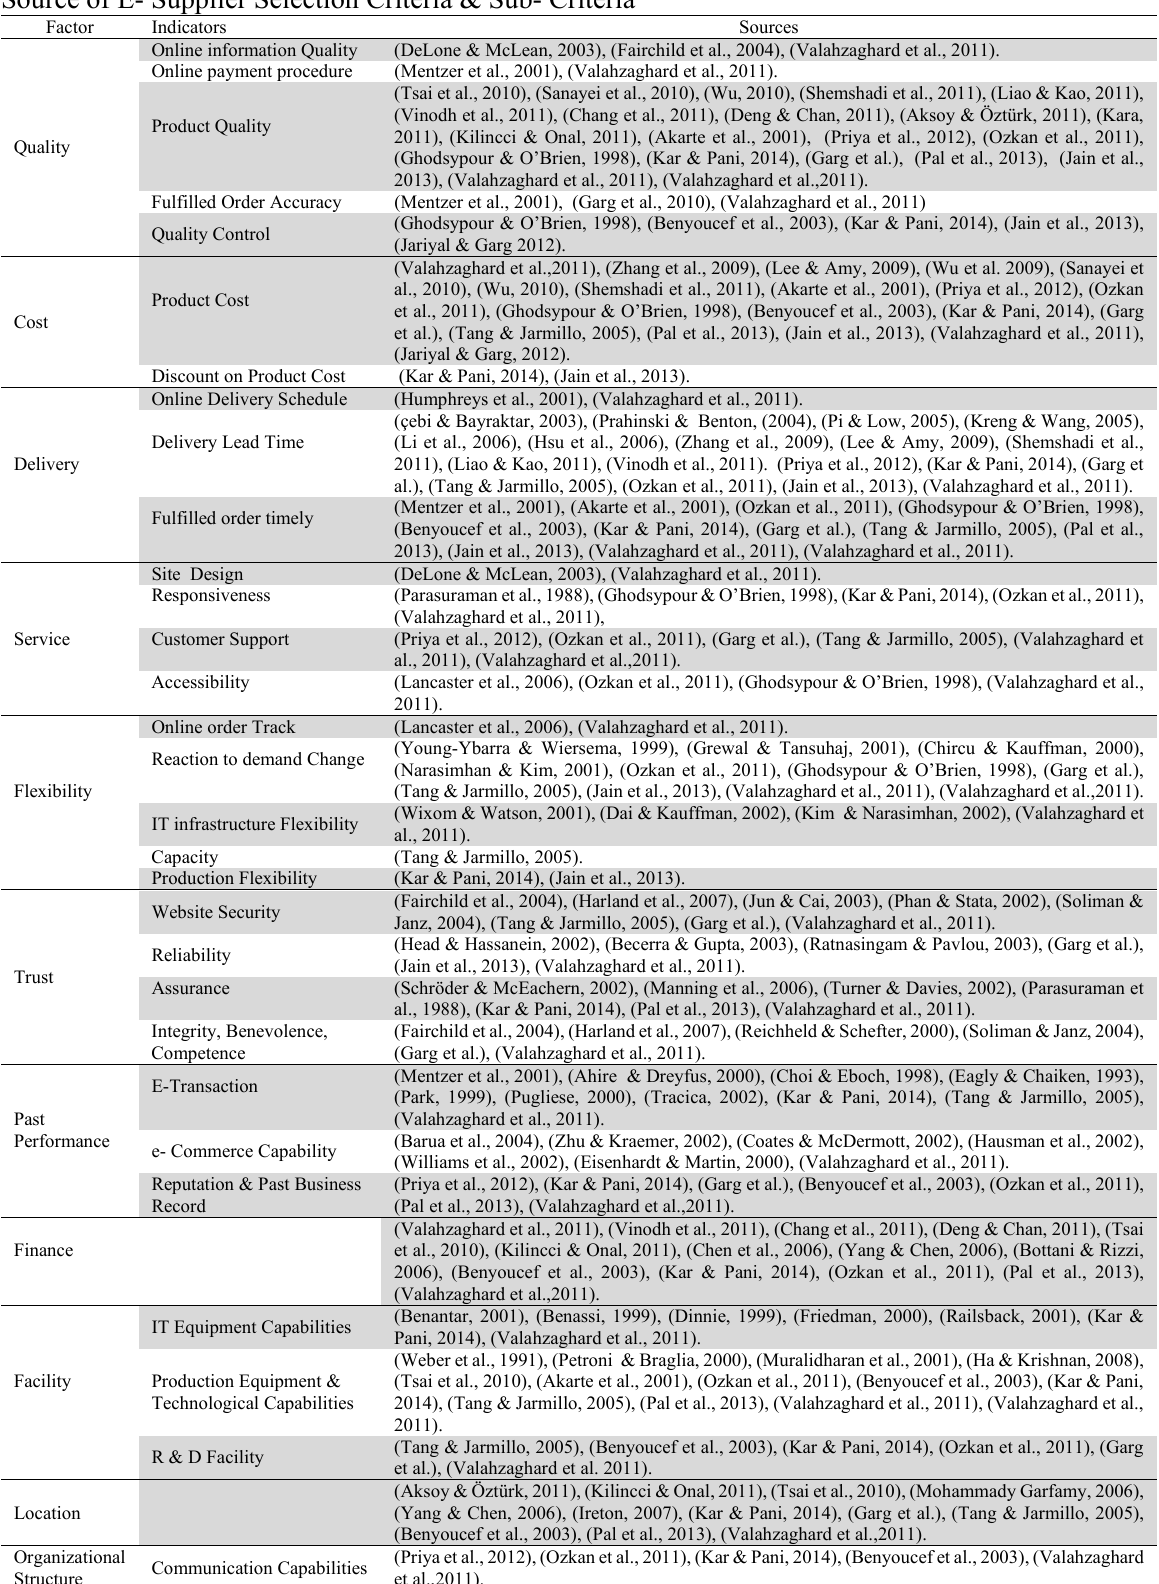
Source of E- Supplier Selection Criteria & Sub- Criteria Factor Indicators Sources